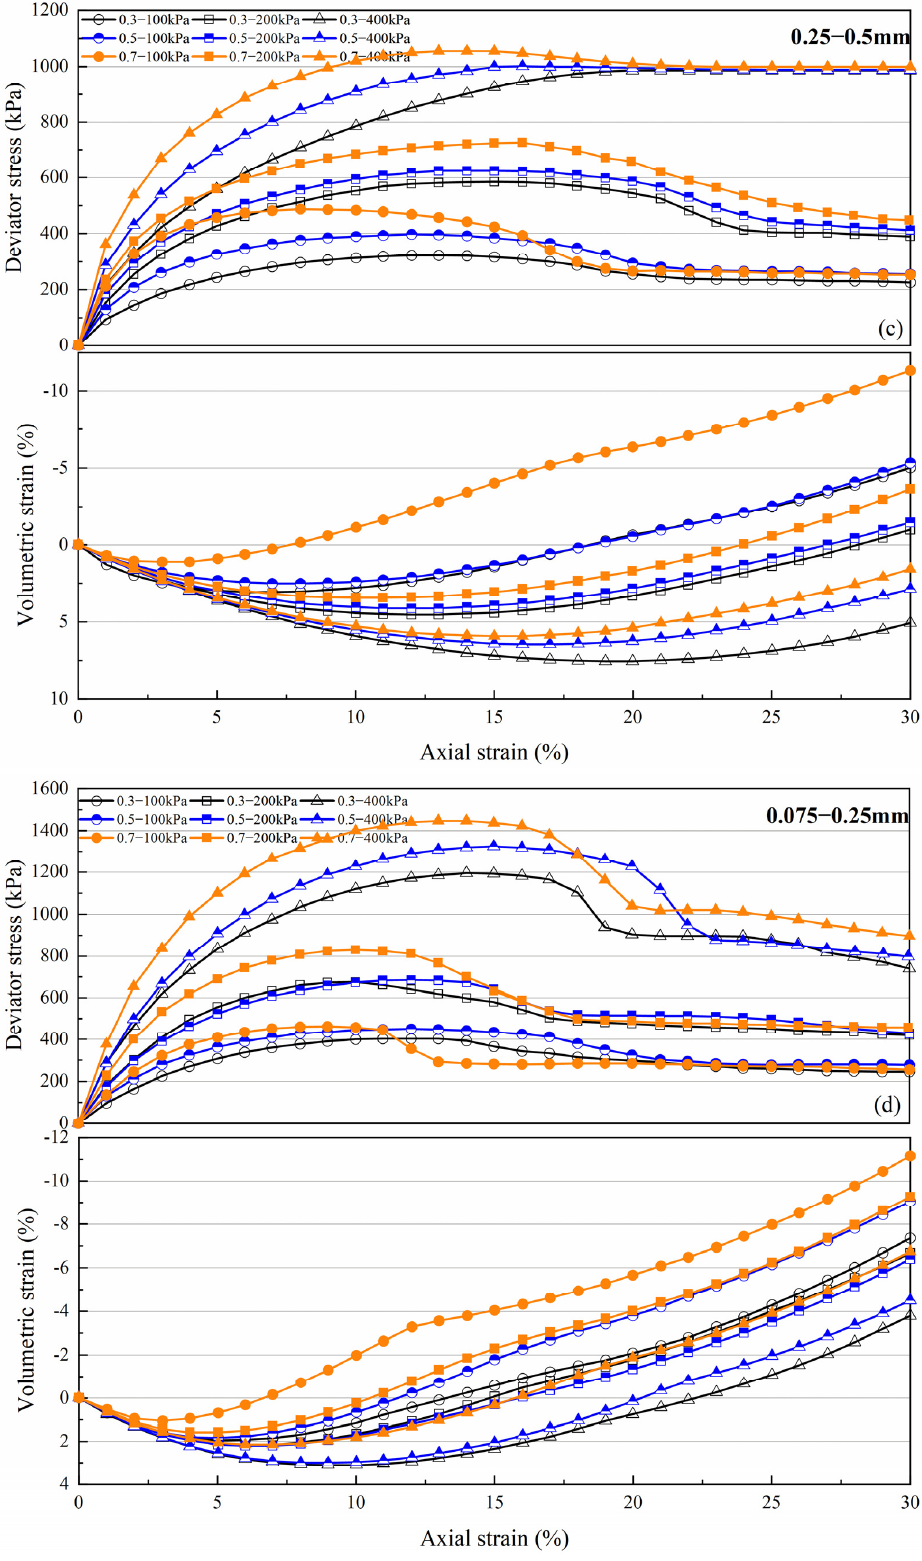
Figure 5. Deviator stress–axial strain–volumetric strain curves of volcanic soil with different relative density ( Dr ) and confining pressure( σ 3 ): ( a ) 2–5 mm particle group; ( b ) 0.5–2 mm particle group; ( c ) 0.25–0.5 mm particle group; ( d ) 0.075–0.25 mm particle group.